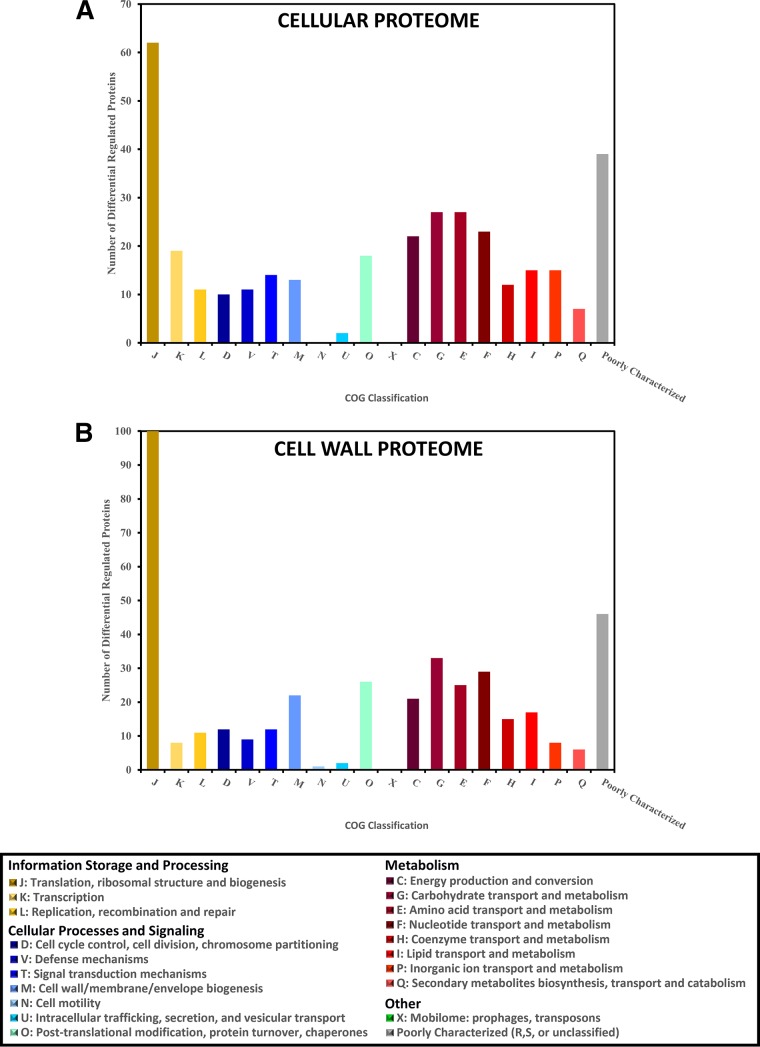
Characterization of differentially expressed proteins based on their COG classification. Proteins that were determined to have a significant 2-fold difference in expression between at least one biofilm time point and one planktonic time point were categorized based on their COG classification. The numbers of proteins in each COG classification are shown for the 320 proteins with differential expression based on cellular proteome data (A) and for the 376 proteins with differential expression based on cell wall proteome data (B). Letter designations refer to the standard COG abbreviations. Numbers sum to greater than 320 or 376 due to some proteins fitting in two or more COG classifications. The “Poorly Characterized” group includes COG classifications R (general function prediction only) and S (unknown function) in addition to unclassified proteins.